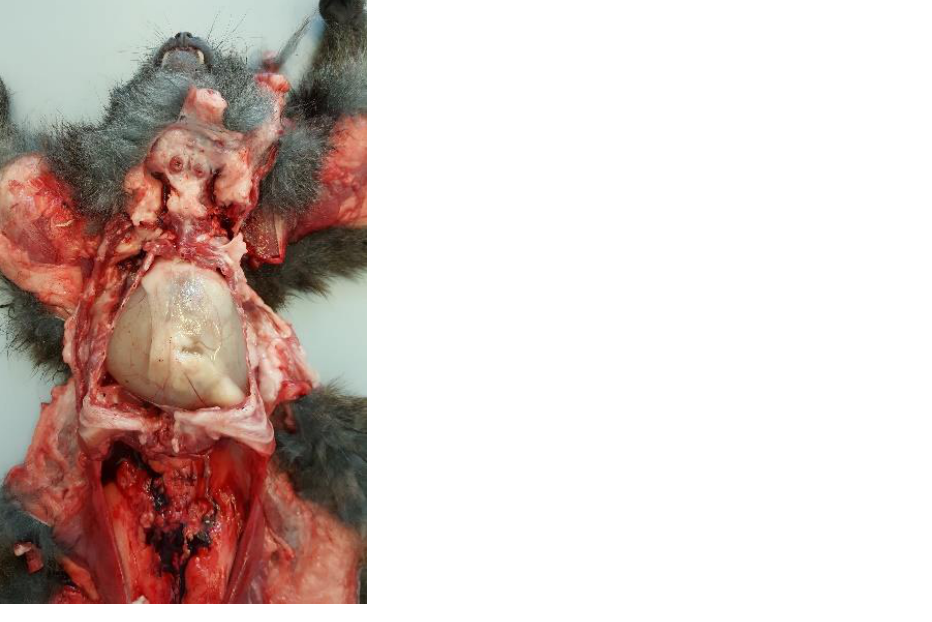
Figure 6. Anatomopathological examination of the thoracic cavity. There is a severe dilatation of the pericardial sac with severe bilateral lung compression.